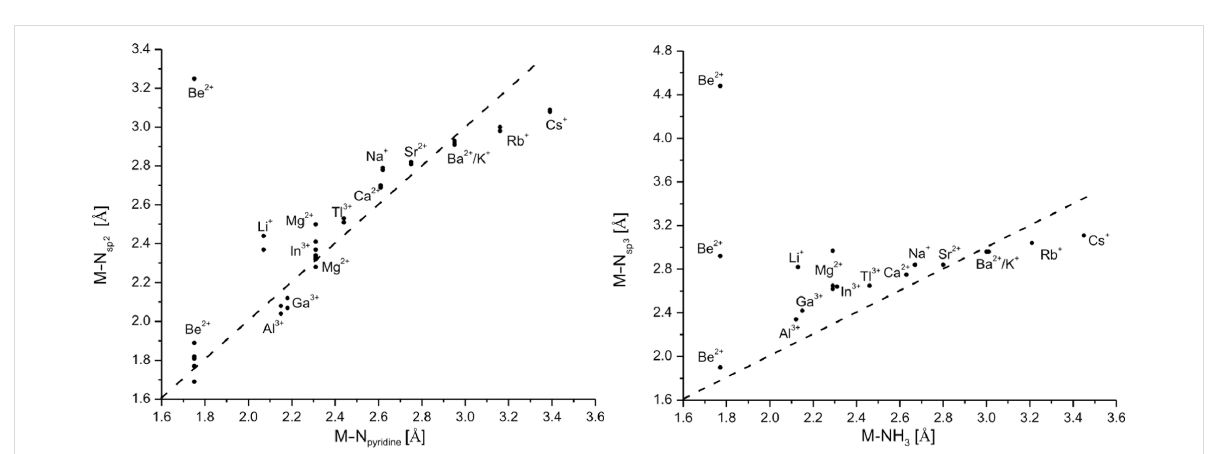
Figure 8: Comparison of the calculated (RB3LYP/LANL2DZp) M–N pyridine /M–N sp2 and M–NH 3 /M–N sp3 coordinating distances for [2.bpy.bpy] (dashed line: bisecting line; for the data see Table 8).